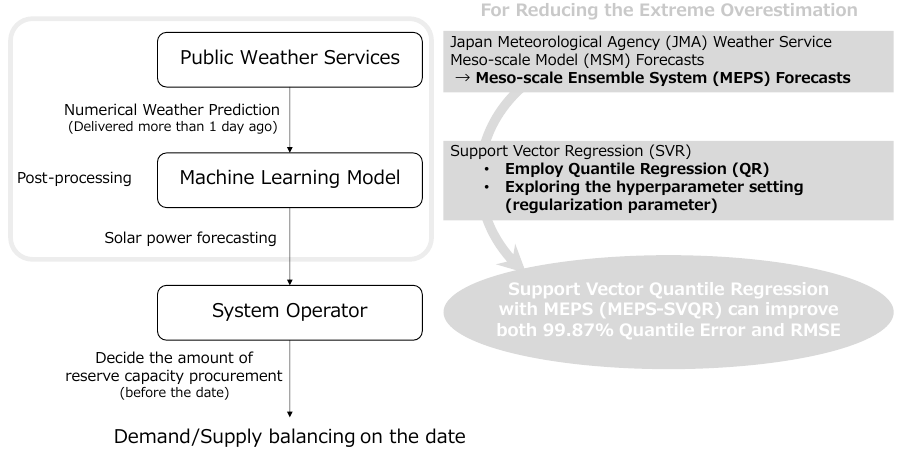
Figure 1. The flow of the short-term solar power forecasting and the correspondence to this paper’s